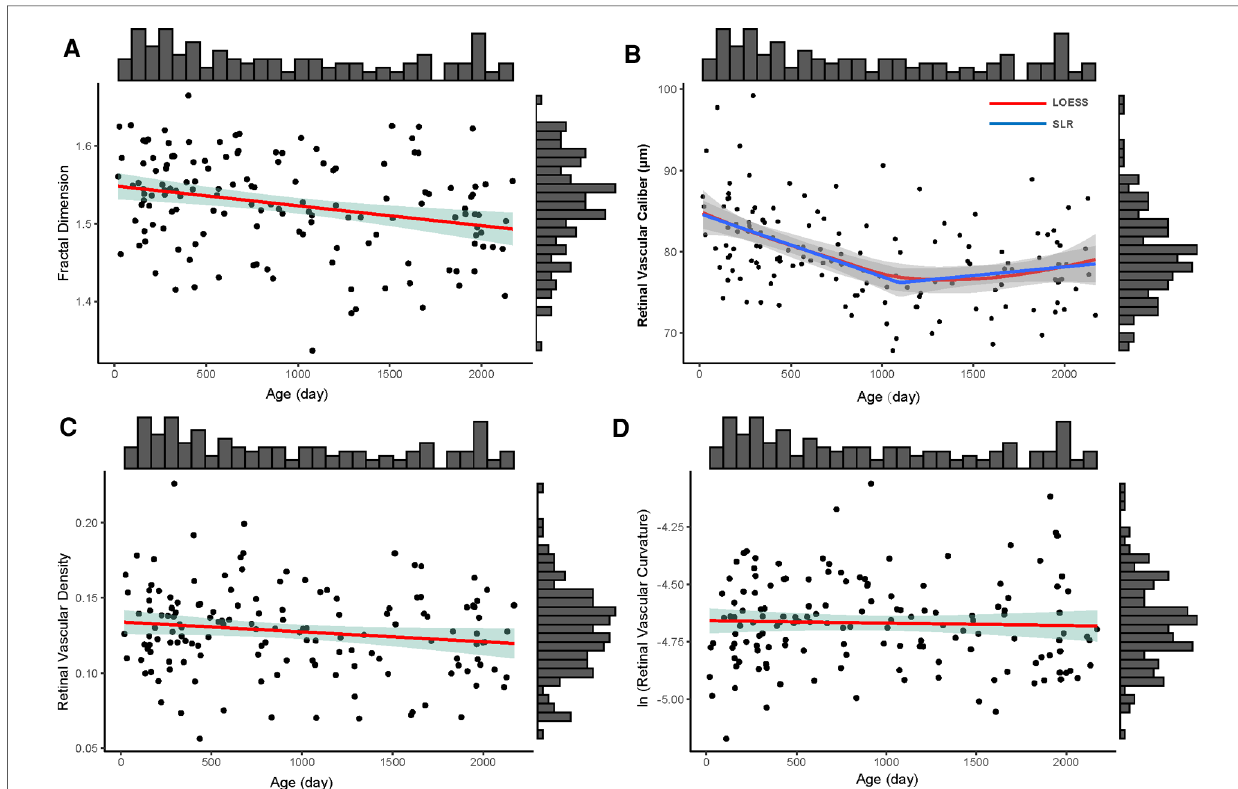
FIGURE 3 The distribution of four retinal vascular parameters with age (day). the upper histogram showed the distribution of the age of 146 included children and the right one showed the distribution of fractal dimension ( A ), retinal vascular caliber ( B ), retinal vascular density ( C ), and retinal vascular curvature ( D ) of 146 included children. ( A ) The distribution of fractal dimension of whole retinal vessels with age; the red line was the linear regression line (y= − 0.000026x+1.549); the green shadow area was the 95% con fi dence interval of the linear regression. ( B ) The distribution of retinal vascular caliber with age; the red line was the locally weighted regression (LOESS) line and the blue line was the segmented linear regression line (SLR, y= − 0.008x+ 84.861, if x<1,095; y=0.0001x+6.148, if x ≥ 1,095); the gray shadow areas around LOESS line and SLR line were their 95% con fi dence intervals, respectively. ( C ) The distribution of retinal vascular density with age; the red line was the linear regression line (y= − 0.000007x+0.134); the green shadow area was the 95% con fi dence interval of the linear regression line. ( D ) The distribution of ln (retinal vascular curvature) (lnC) with age. The red line was the linear regression line (lnC= − 0.00001x − 4.657); the green shadow area was the 95% con fi dence interval of the linear regression